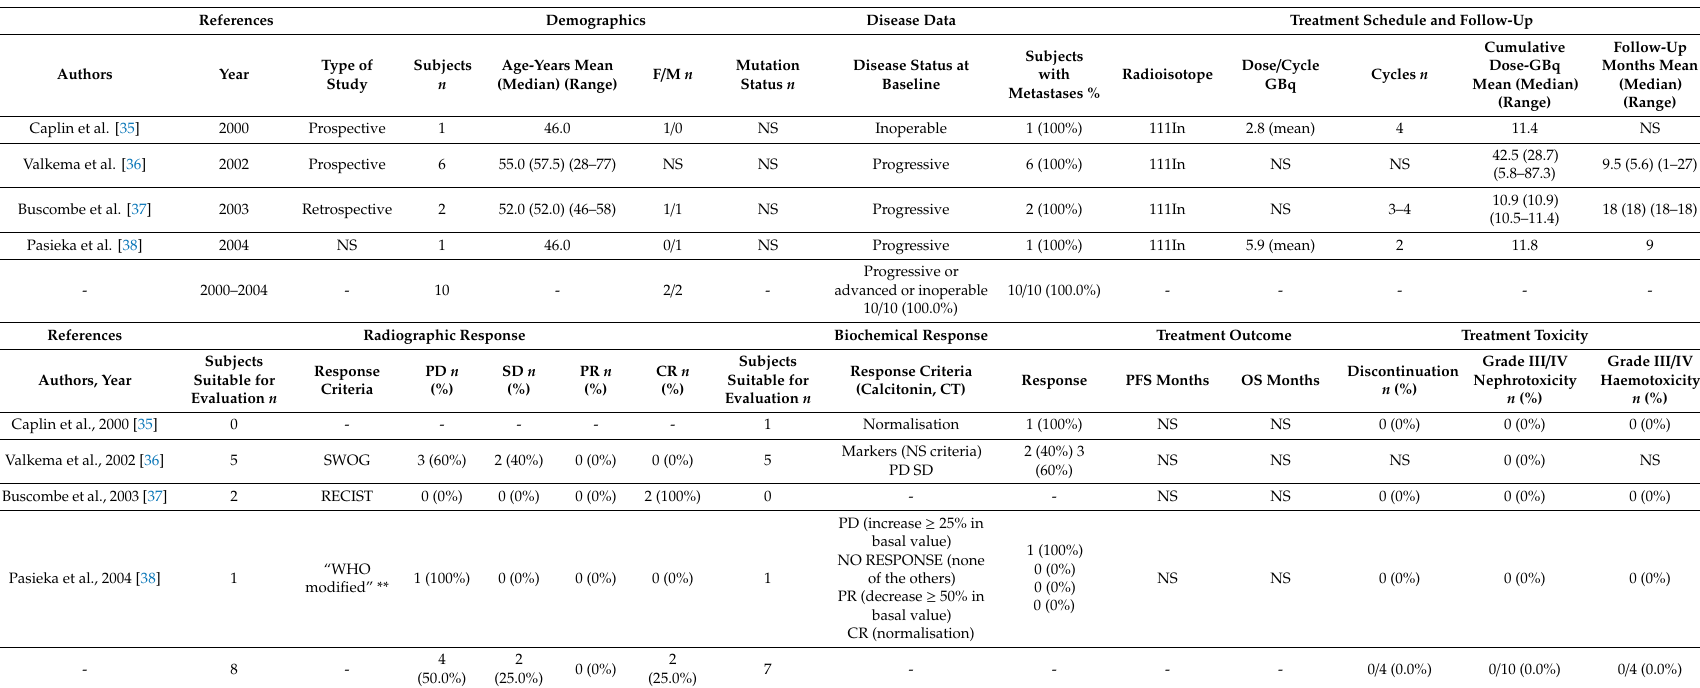
Table 2. PRRT targeting SSRs with 111In-SSA in